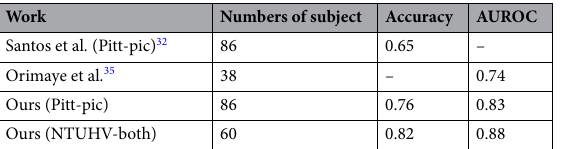
Table 8. Related works of the performance of MCI vs. HC on Pitt datasets. "–"means that the statistics is not reported.